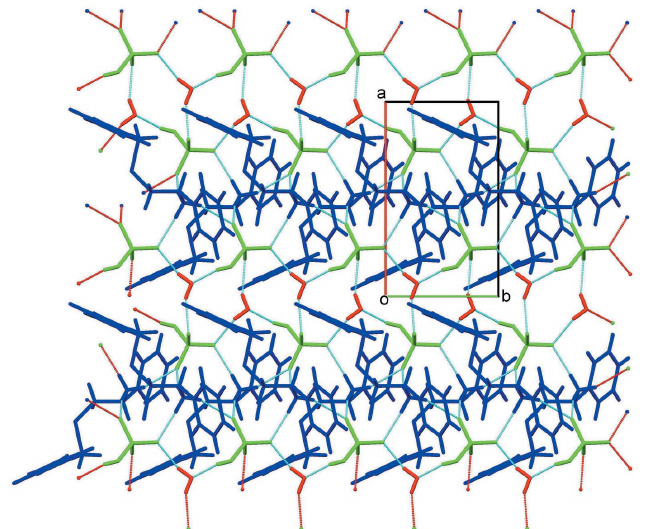
Figure 3 A partial view along the c axis of the crystal packing of the title salt, showing the formation of a two-dimensional sheet along the ab plane. The various intermolecular interactions (Table 1) are shown as dashed lines. Colour key: green, anions; red, water; blue,